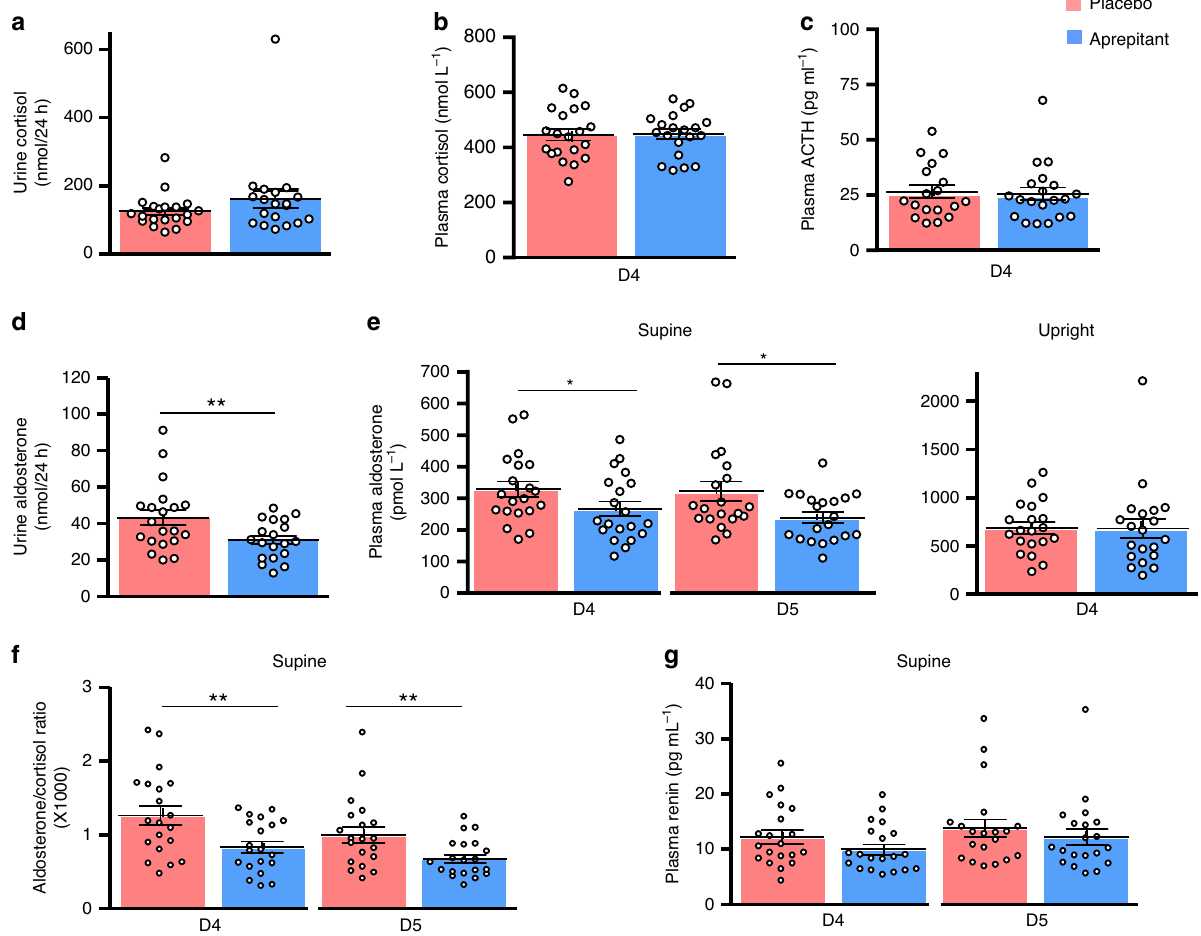
Fig. 6 Effect of oral administration of the NK1R antagonist aprepitant versus placebo on corticosteroid concentrations in healthy volunteers. a – c Effect of placebo or aprepitant on 24-h urinary cortisol excretion (CI 95%: 102 – 147 versus 103 – 219; p = 0.18), basal (8:00 a.m.) plasma cortisol (CI 95%: 403 – 489 versus 411 – 485; p = 0.89) and ACTH levels (CI 95%: 20 – 32 versus 19 – 31; p = 0.43) at day 4 (D4; 4th day of treatment). d , e Effect of placebo